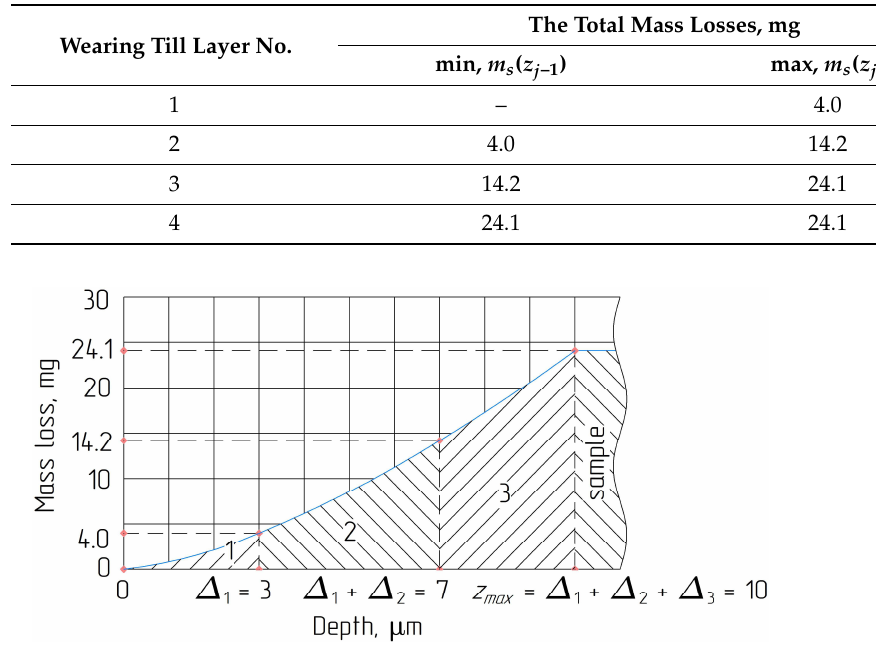
Figure 3. Mass losses distribution.